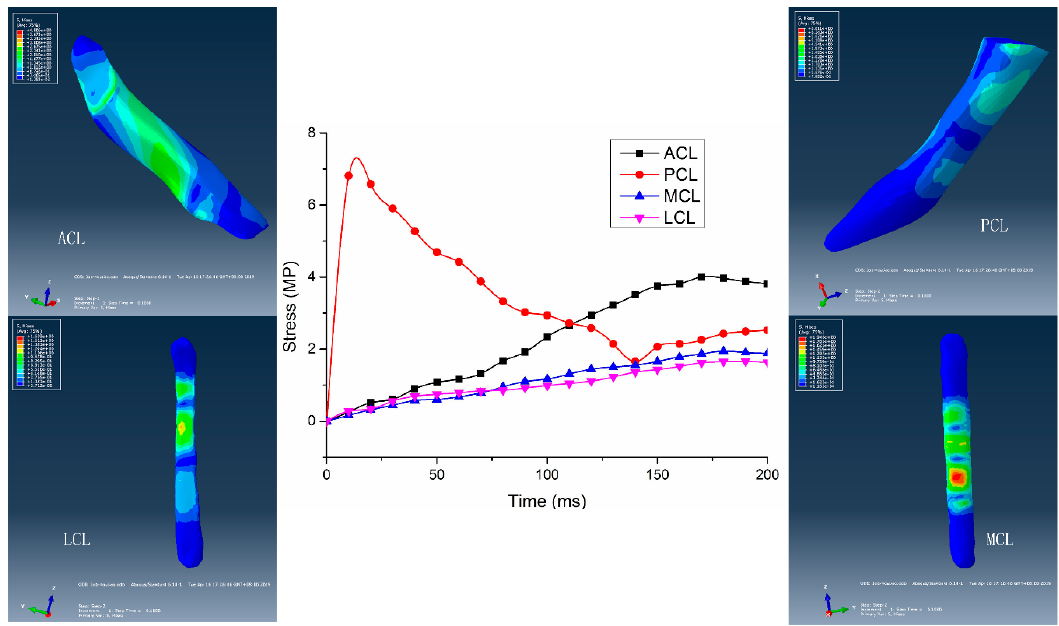
Figure 7. Stress distribution and stress-time curve of the ligaments in forward landing.